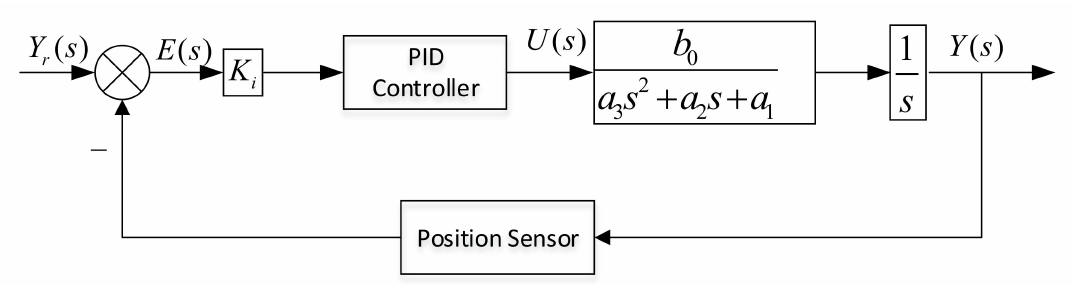
Figure 12. Block diagram of the displacement and acceleration feedback